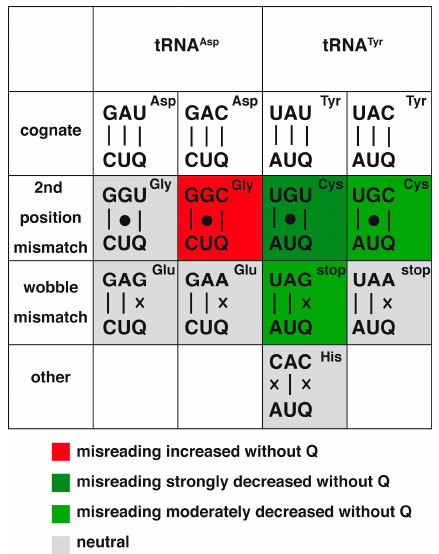
Figure 4. Effects of Q modification on mistranslation in bacteria [56]. Codon ‐ anticodon pairs of tRNA Asp and tRNA Tyr are shown with the codon at the top and the anticodon at the bottom. The respective amino acid is indicated in the corner. First row, cognate codons for tRNA Asp and tRNA Tyr . Second row, base mismatches at the second codon position that showed significant misreading in vivo [46]. Third row, wobble mismatches that showed significant misreading in vivo. Red color indicates that the codon showed increased misreading when the respective tRNA was not Q-modified. If the respective codon showed strongly or moderately decreased misreading in the absence of Q modification, the boxes are colored in dark green or light green, respectively. Grey, no effect of Q modification on misreading.